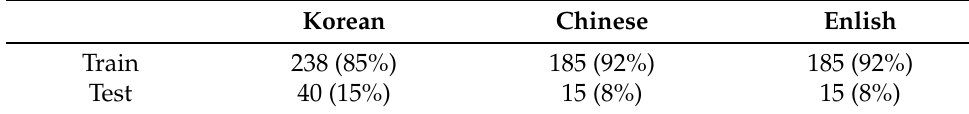
Table 2. Number (ratio) of training and test fonts for each